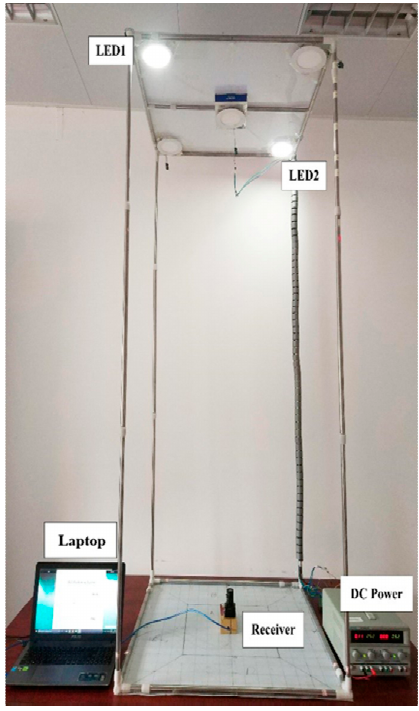
Figure 7. The experimental platform of VLP system based on double-light positioning algorithm. Appl. Sci. 2019 , 9 , x FOR PEER REVIEW